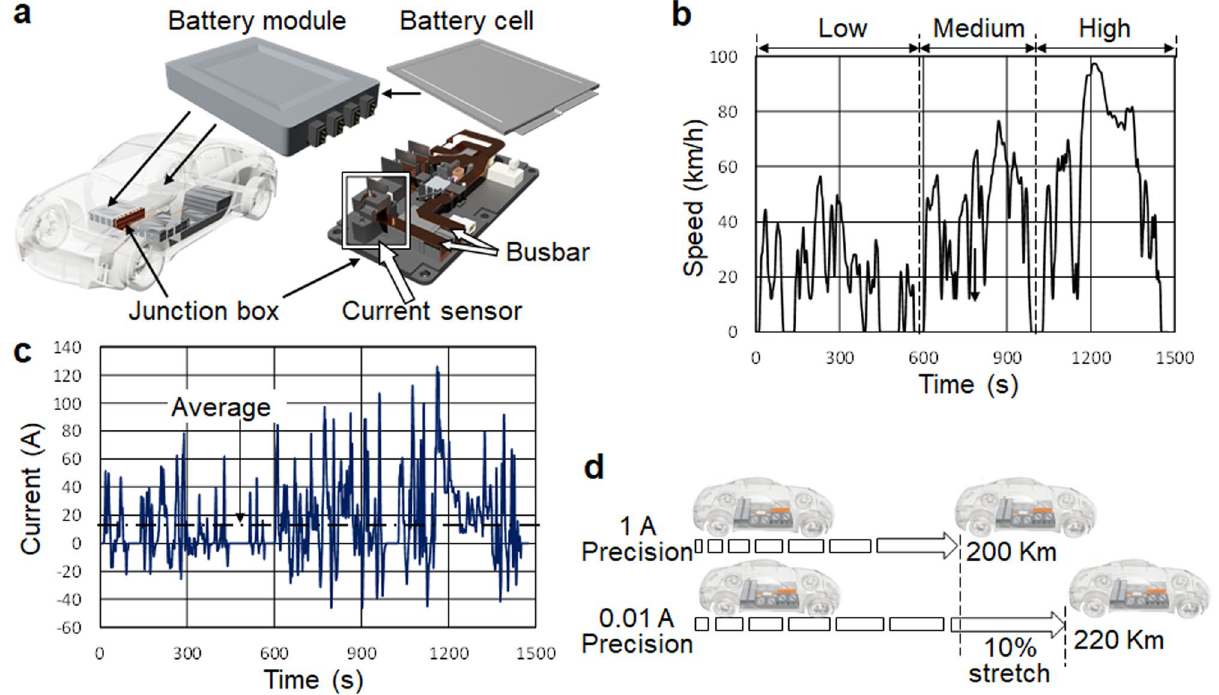
Figure 1. ( a ) Battery current sensor usage in the EV. Currents from the battery module with stacked battery cells pass through the busbar in the junction box and measured by the current sensor. ( b ) Driving speed (km/h) and ( c ) Converted current in the WLTC (Worldwide Harmonized Light Vehicles Test Cycle) mode 1 assuming a typical automobile weighing 1500 kg. The maximum is 126 A and the average 14 A. ( d ) Effect of the highly accurate current sensor on stretching the EV’s driving range. Estimating the battery state of charge based on the current sensor with 1 A accuracy requires 10% margin, which can be eliminated with 0.01 A accuracy